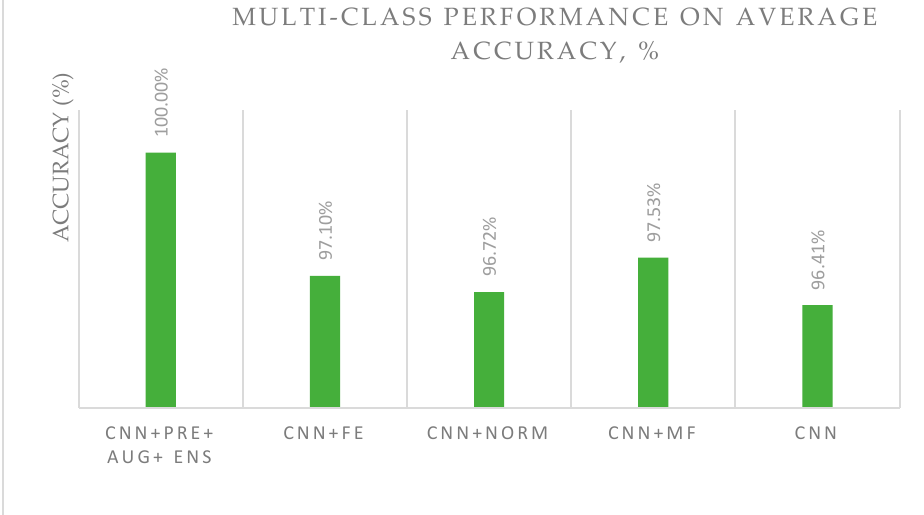
Figure 4. Multi-class classification accuracy of the popular and best classification approaches.